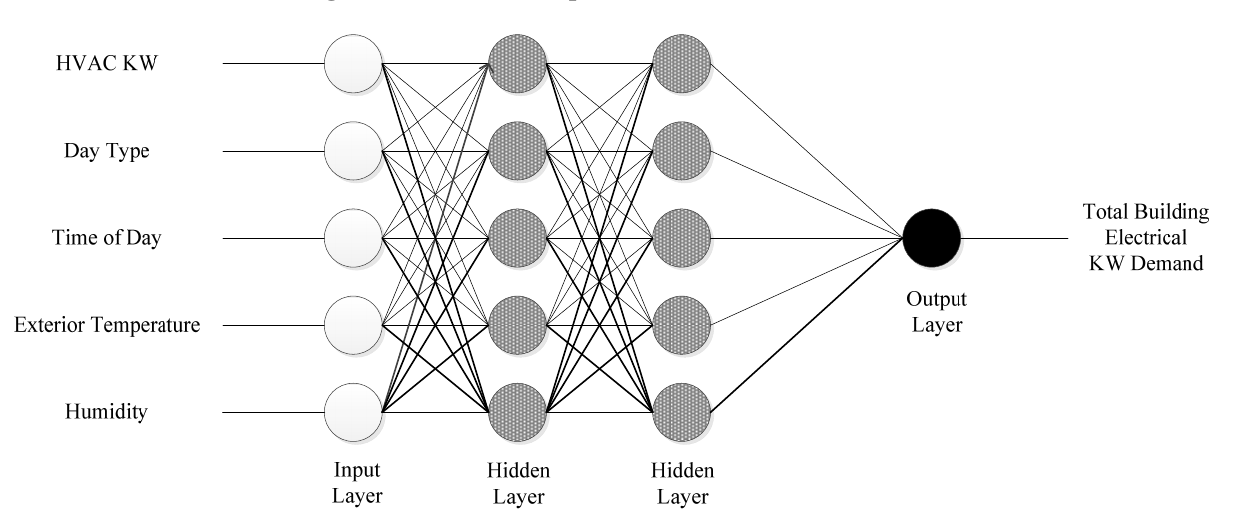
Figure 3. Final developed neural network